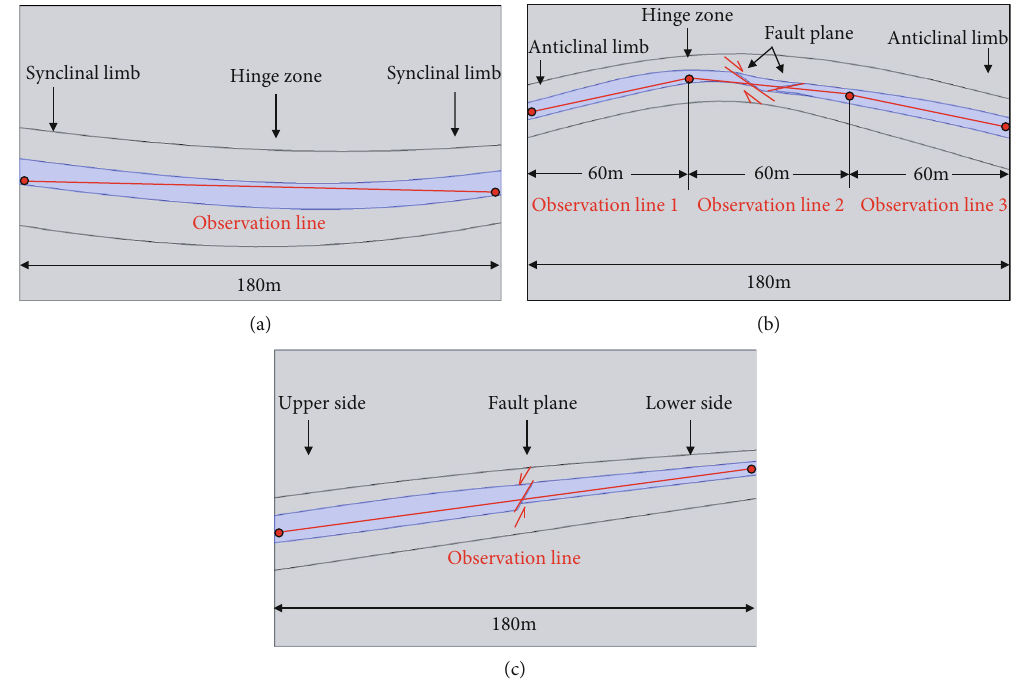
Figure 6: Location of monitoring lines near di ff erent structural sites: (a) X3 syncline monitoring line; (b) B1 anticline and F10 fault monitoring lines; (c) F11 fault monitoring line.